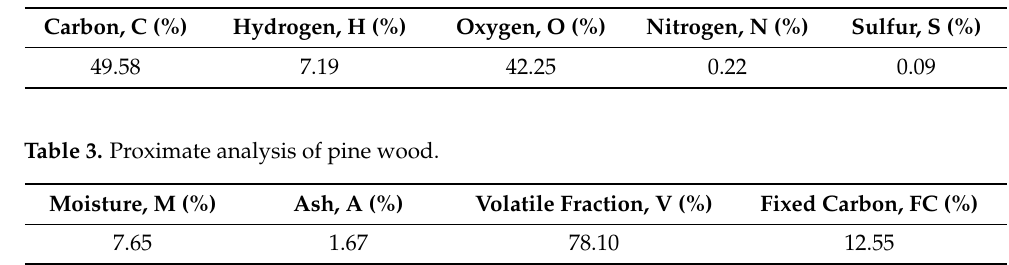
Table 2. Elemental analysis of pine wood.